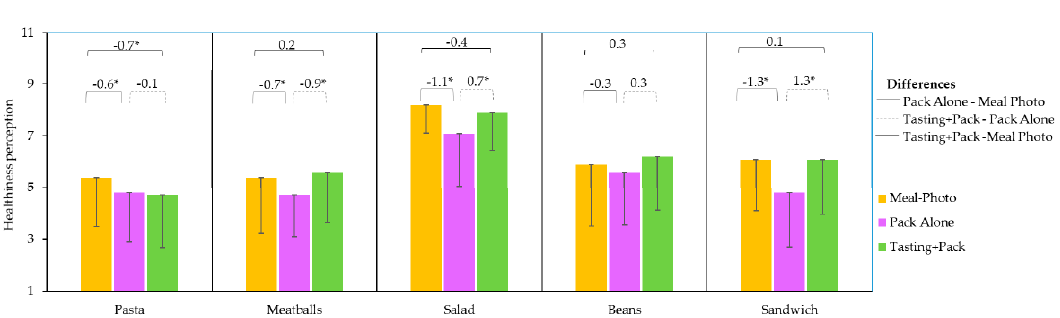
Figure 7. Healthiness perception mean values of each of the five meals evaluated on a plate (Meal-Photo condition), in the pack (Pack Alone condition), and after tasting with the packaging in view (Tasting+Pack condition). Differences between conditions (Pack- Meal Photo, Tasting Pack-Pack and Tasting pack- Meal Photo) are indicated with line segments over the top of the corresponding columns; significant differences are marked with an asterisk (*). Only the negative part of the standard deviation bars are shown for clarity.